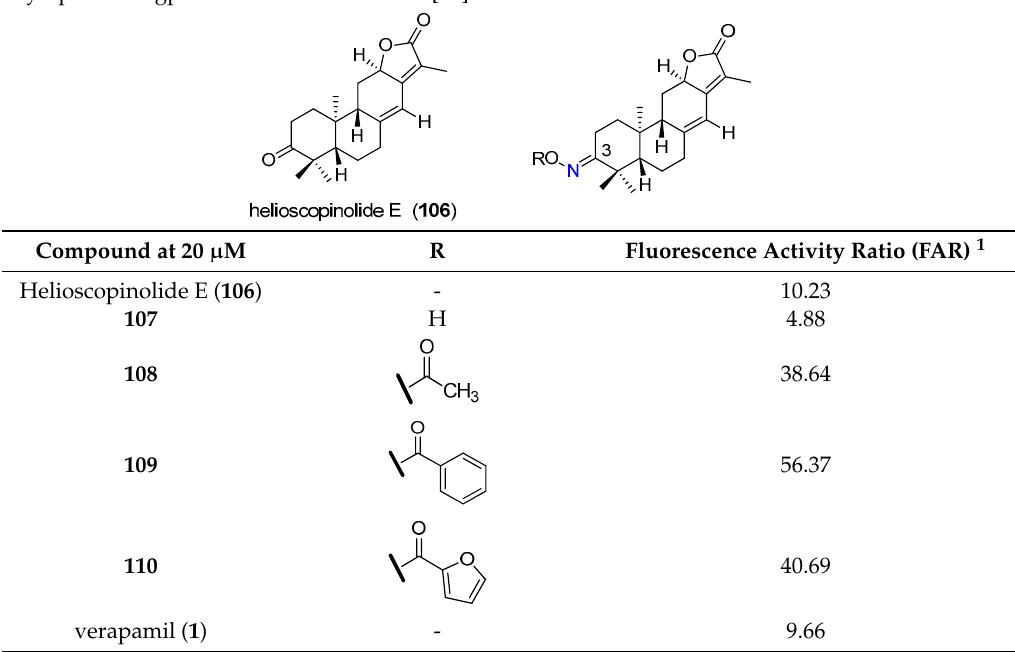
Table 12. P-gp modulatory activity of helioscopolide E ( 106 ) and its derivatives 107 – 110 on mouse T- lymphoma P-gp-transfected L5178Y cells [82].